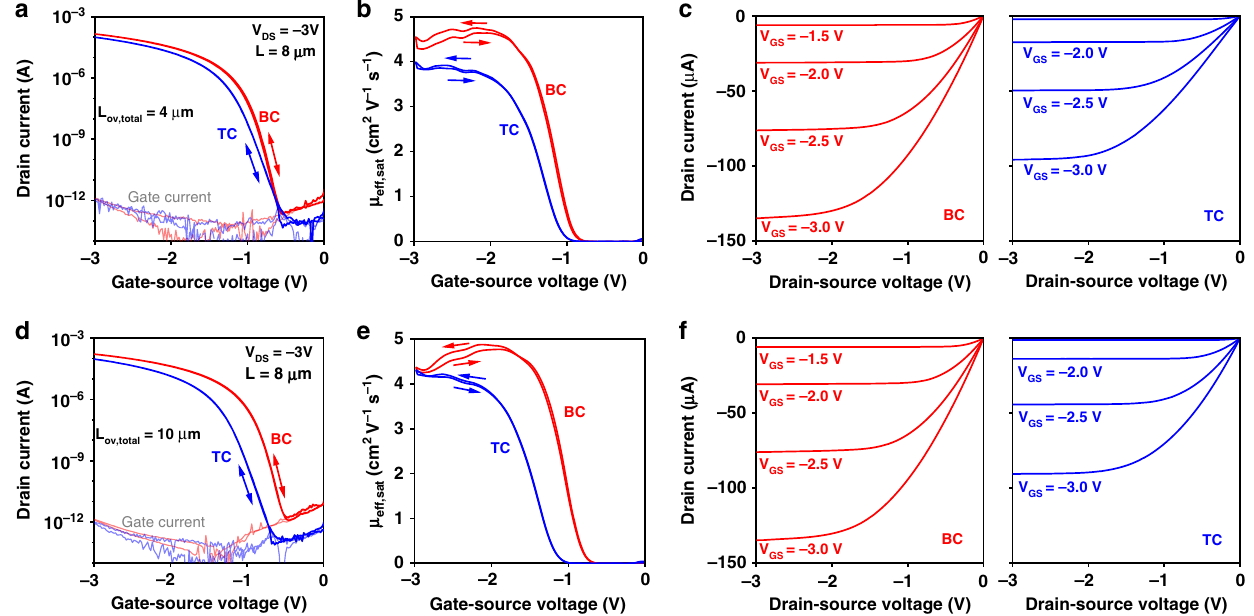
Fig. 6 Static electrical characteristics of bottom-contact and top-contact DPh-DNTT TFTs on fl exible PEN substrates. The TFTs have a gate-dielectric thickness of 5.3 nm, a channel length of 8 µ m, a channel width of 200 µ m, and a total gate-to-contact overlap of 4 µ m ( a – c ) or 10 µ m ( d – f ). a , d Transfer characteristics measured in the saturation regime ( V DS = − 3 V). b , e Effective carrier mobility extracted from the transfer characteristics in the saturation regime ( V DS = -3 V). c , f Output characteristics of the same TFTs